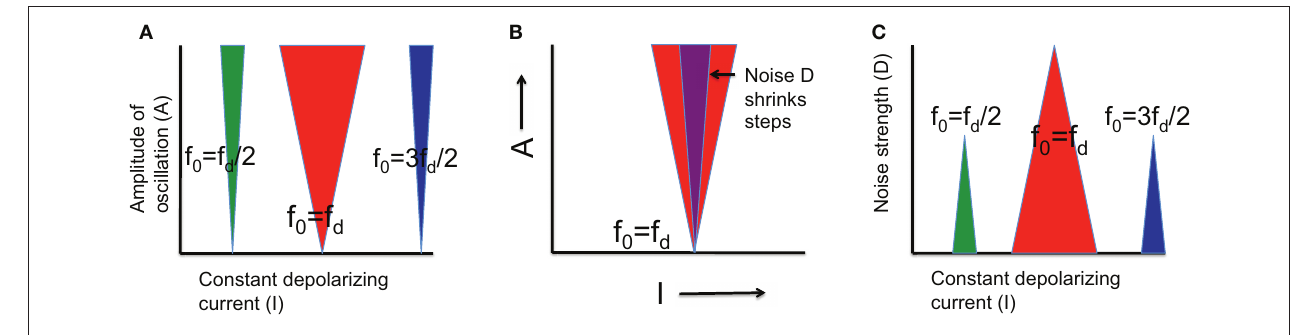
phase-locked solutions at the edges, thereby reducing the width of the phase-locking steps. (C) The effect of noise is better illustrated by fixing the amplitude A and varying the noise strength D. Phase-locking steps shrink as D = (1/2) f ; (red) the 1:1 step 0 d increases until they finally disappear. The 1:1 step is the most stable because it = (3/2) f . The steps have 0 0 d persists even when the other steps have already disappeared. The detailed description of these results can be found in Tiesinga (2002) for the case where f is varied rather than f via d 0